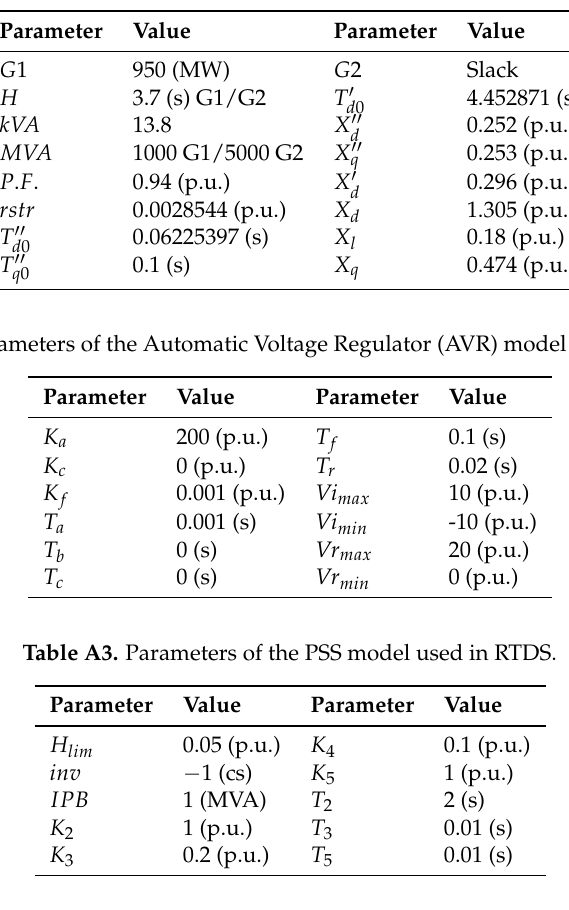
Table A1. Parameters of the synchronous generators.